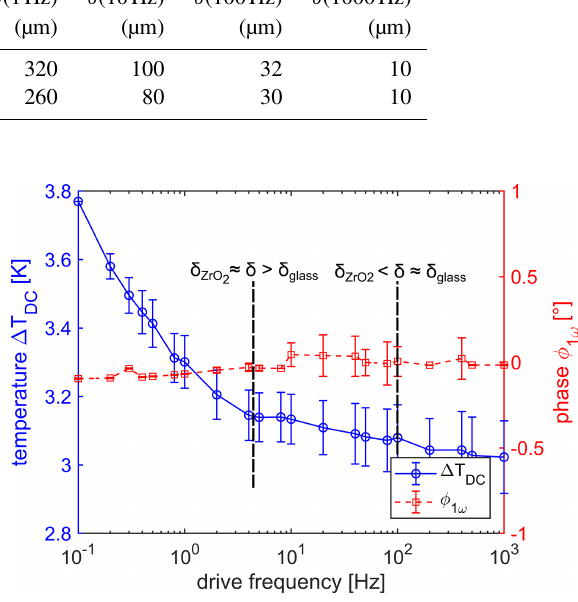
Figure 3. (a) Electrical diagram of the measurement hardware. The core part is a data acquisition card from National Instruments (NI USB 6225) which generates the drive signal and measures the volt- age across the resistor. The entire setup is controlled by a computer via LabView. (b) The platinum thin-film sensor is mounted on a stainless steel rod to form a suitable probe.